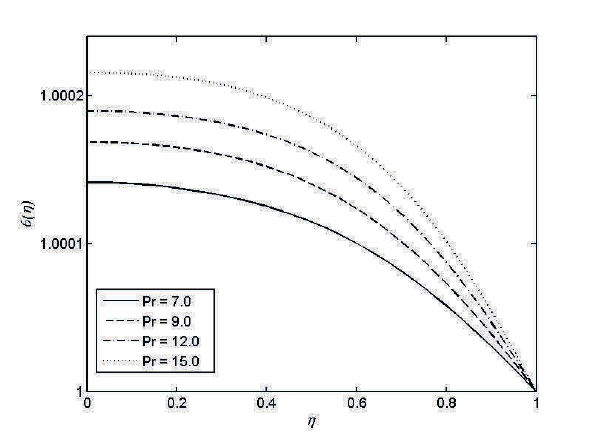
Fig. 5: Variation of f (cid:2) ( η ) for different values of λ 1 for λ 2 = 1 and M = 0.5.